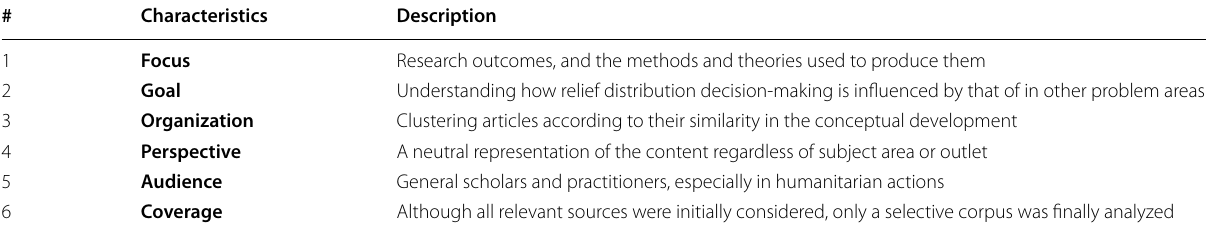
Table 1 Categorizations in the literature review (adapted from Cooper 1988)